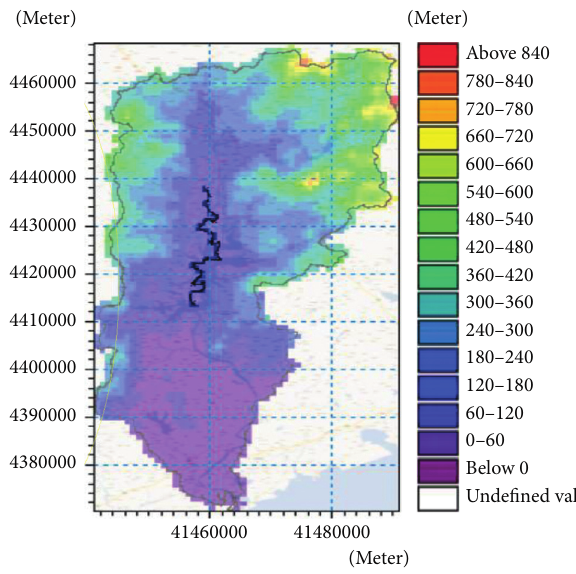
Figure 5: Coupled river pattern of MIKE 11/MIKE